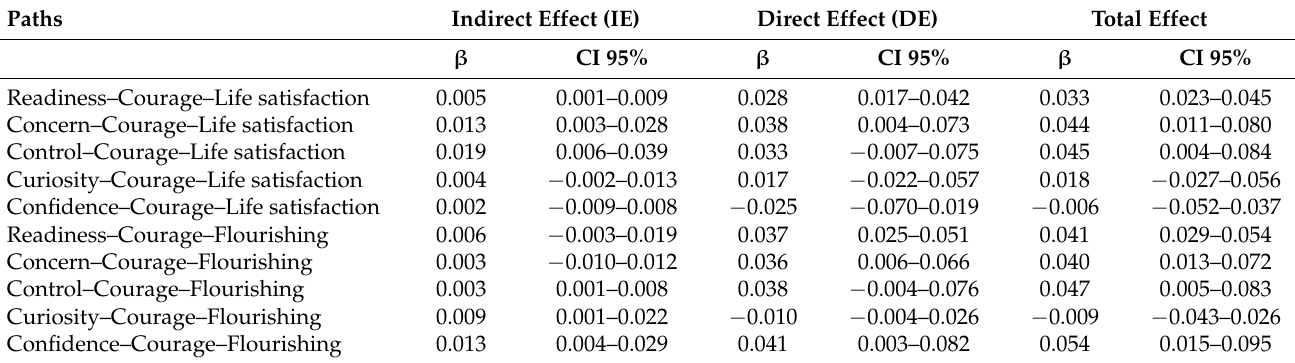
Table 3. Effects of readiness and the four dimensions of career adaptability on life satisfaction and flourishing through courage (standardized β ).